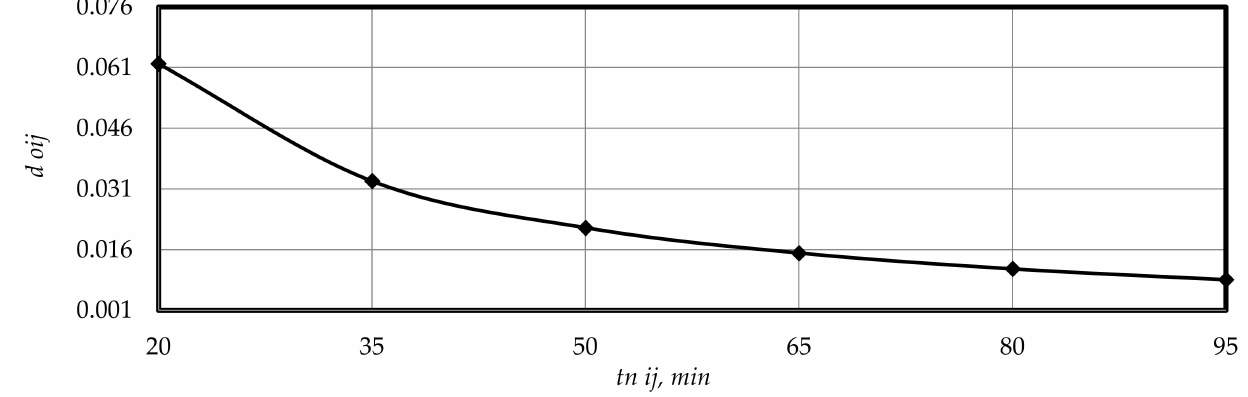
Figure 5. Graph of the change in trip distribution function of urban employers of service enterprises depending on the time of movement between